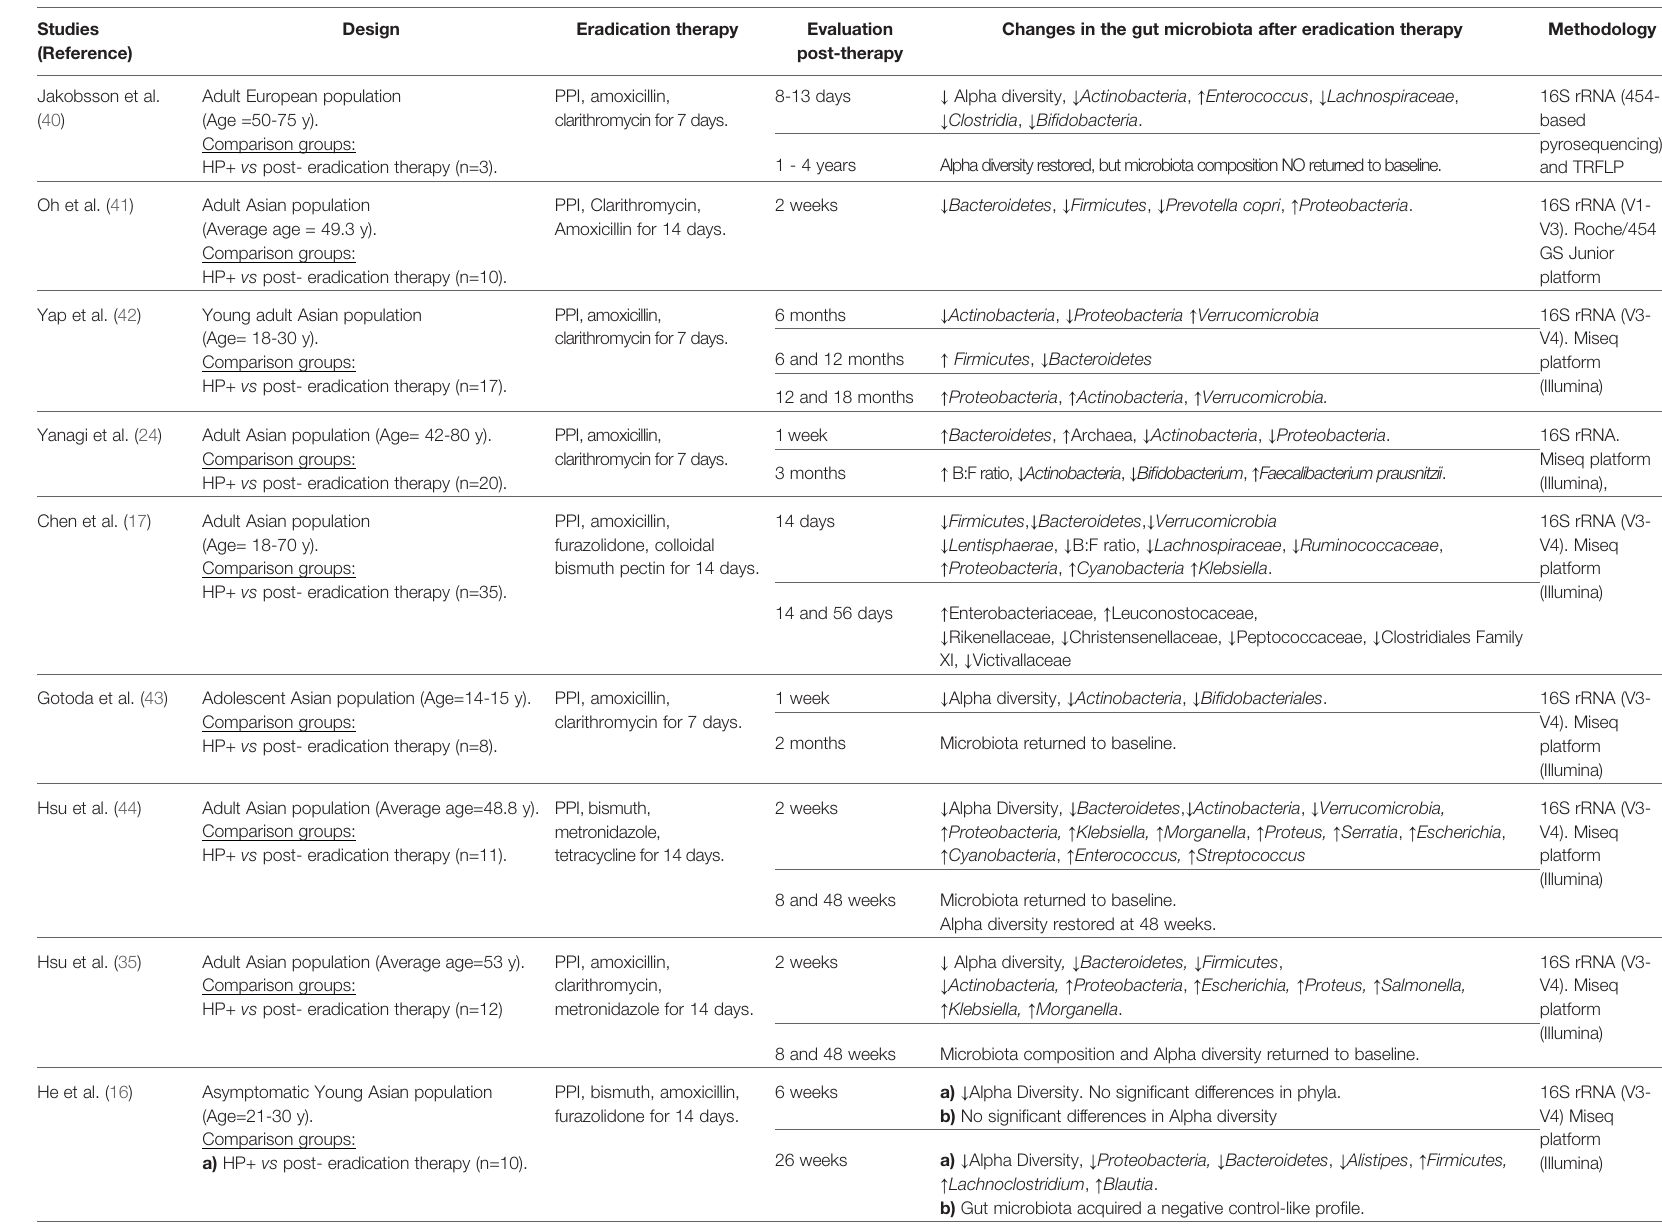
TABLE 2 | Effect of antibiotic H. pylori eradication therapies on gut microbiota composition in human studies. Studies